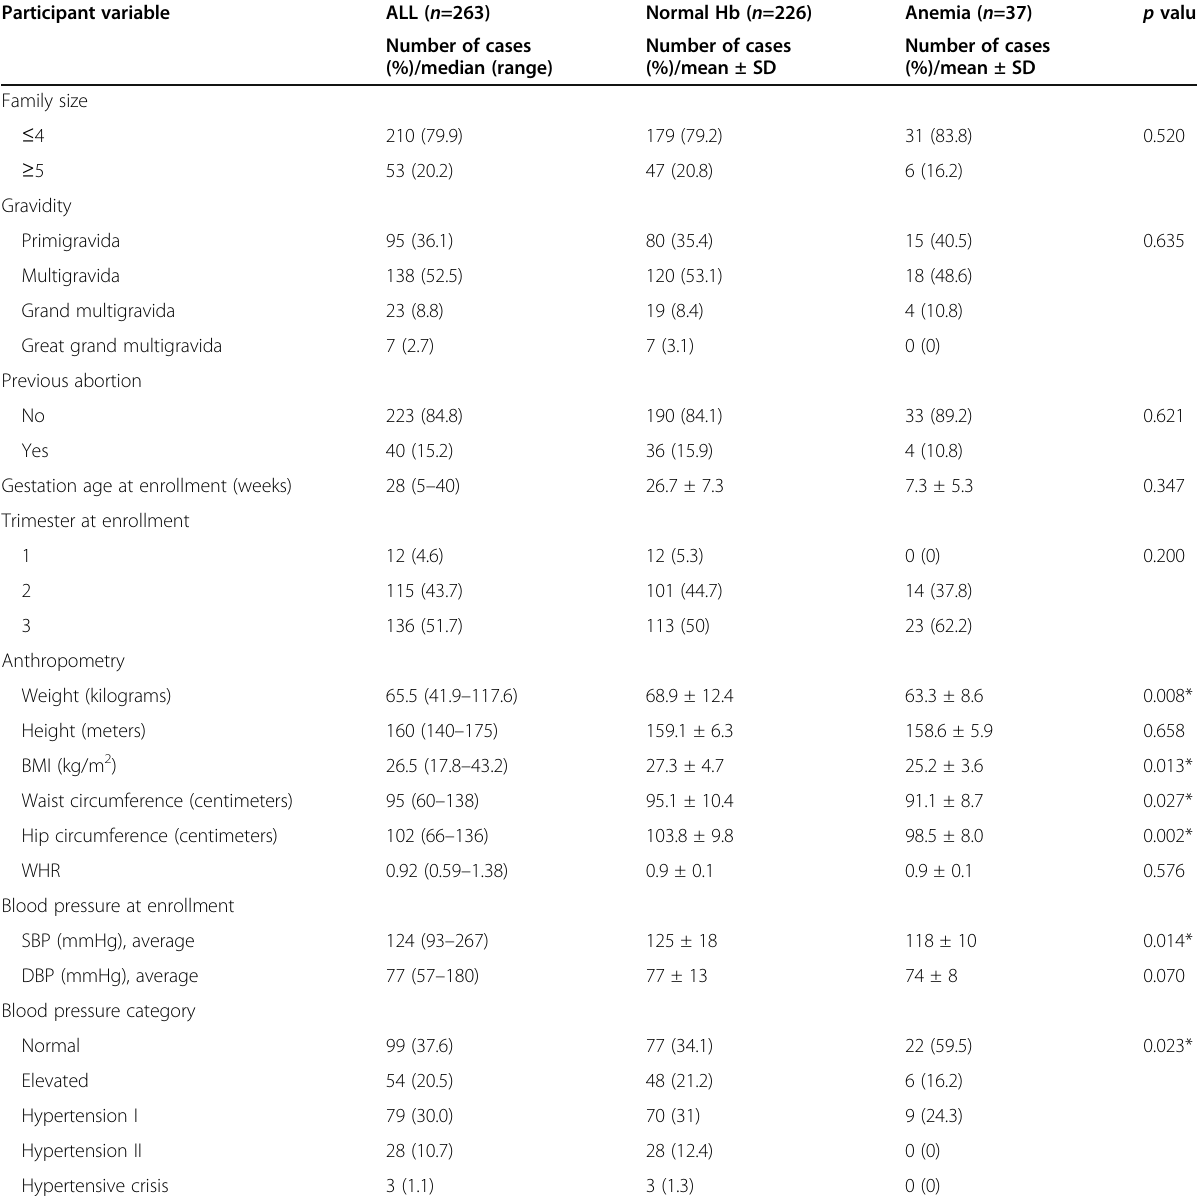
Table 1 Bivariate analysis for socio-demographic and anthropometric factors associated with anemia in pregnancy (Continued) Participant